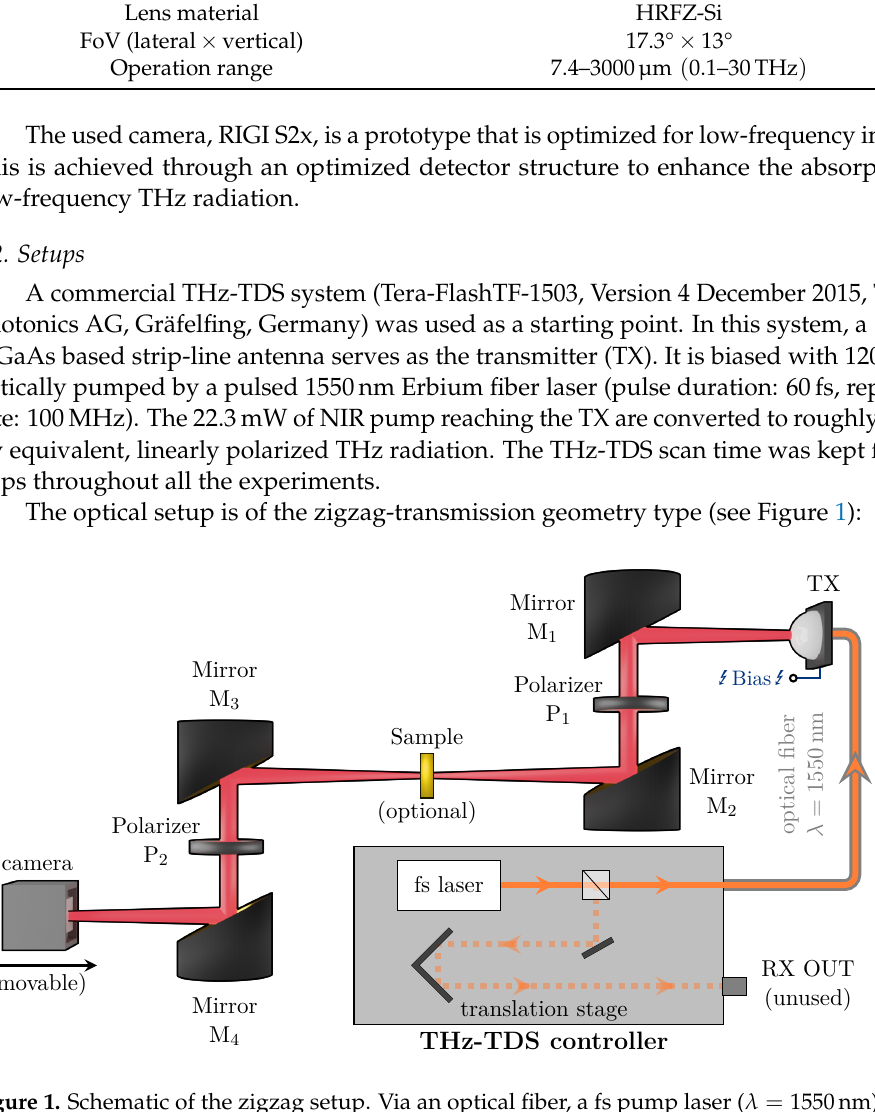
Figure 1. Schematic of the zigzag setup. Via an optical fiber, a fs pump laser ( λ = 1550nm) excites the TX, which, in turn, emits THz radiation. Four OAPMs M 1 ( f = 89mm), M 2 ( f = 178mm), M 3 ( f = 178mm) and M 4 ( f = 89mm) and two polarizers, P 1 and P 2 , guide the THz emission onto the camera sensor (positioned where in a THz-TDS the RX would be